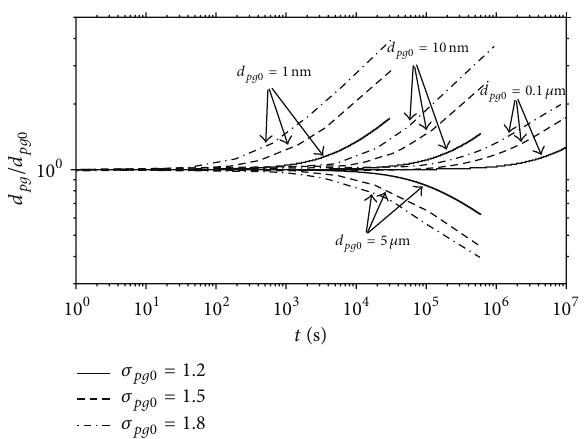
Figure 4: Effect of RSD on particle number concentration for Cases6–9.